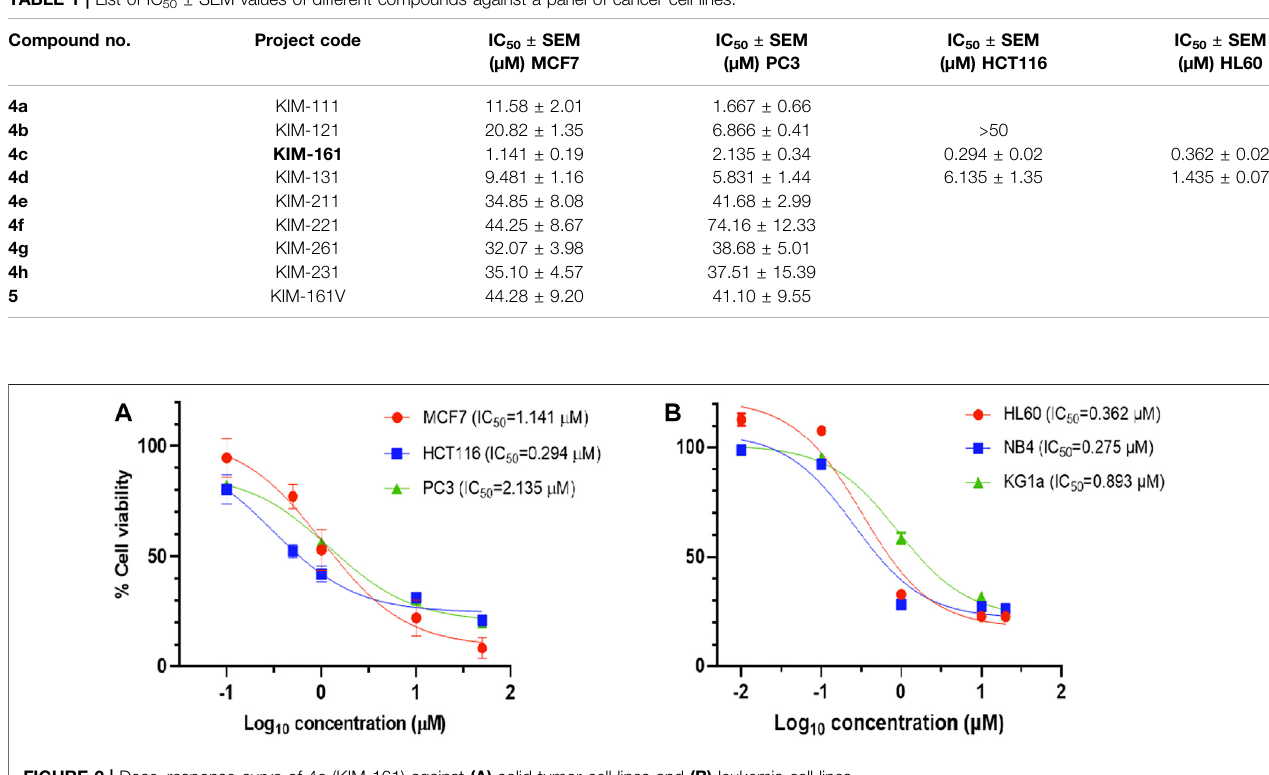
FIGURE 2 | Dose – response curve of 4c (KIM-161) against (A) solid tumor cell lines and (B) leukemia cell